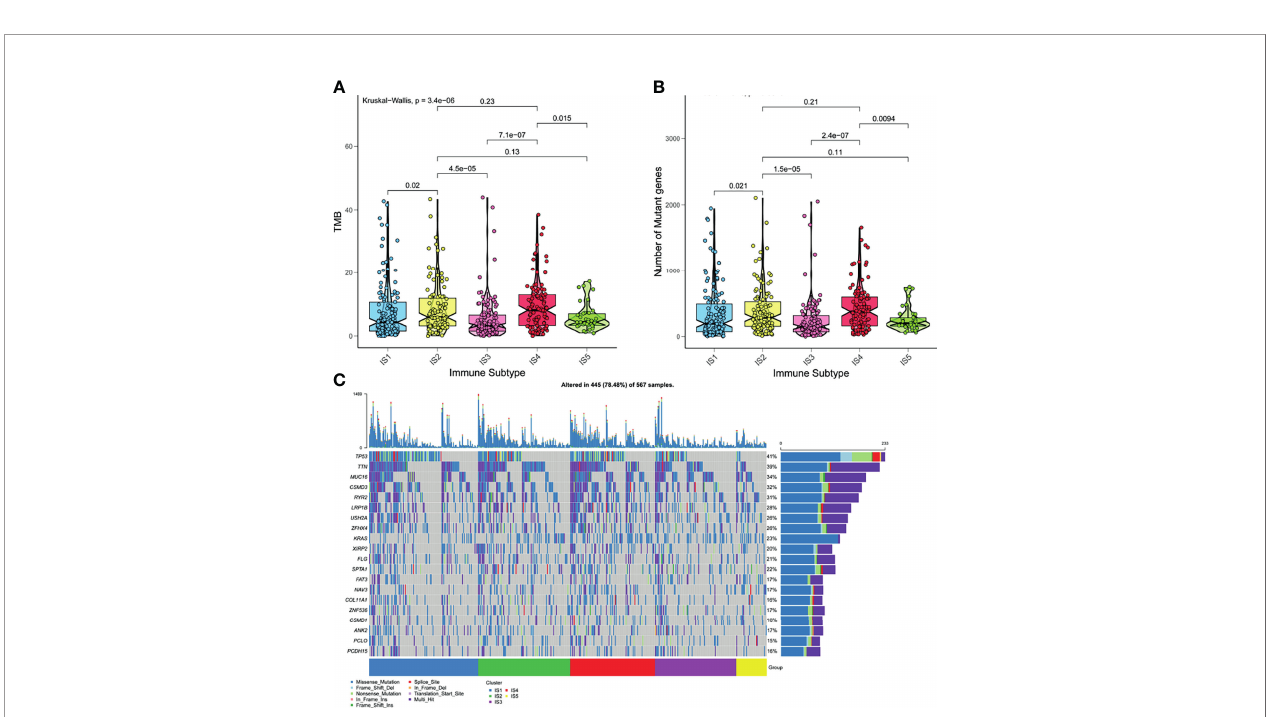
FIGURE 5 | The correlation of LUAD-related ISs and mutation. (A) TMB in fi ve ISISs. (B) The number of somatic mutations in fi ve ISISs. (C) The distribution of nineteen highly mutated genes in fi ve ISISs of